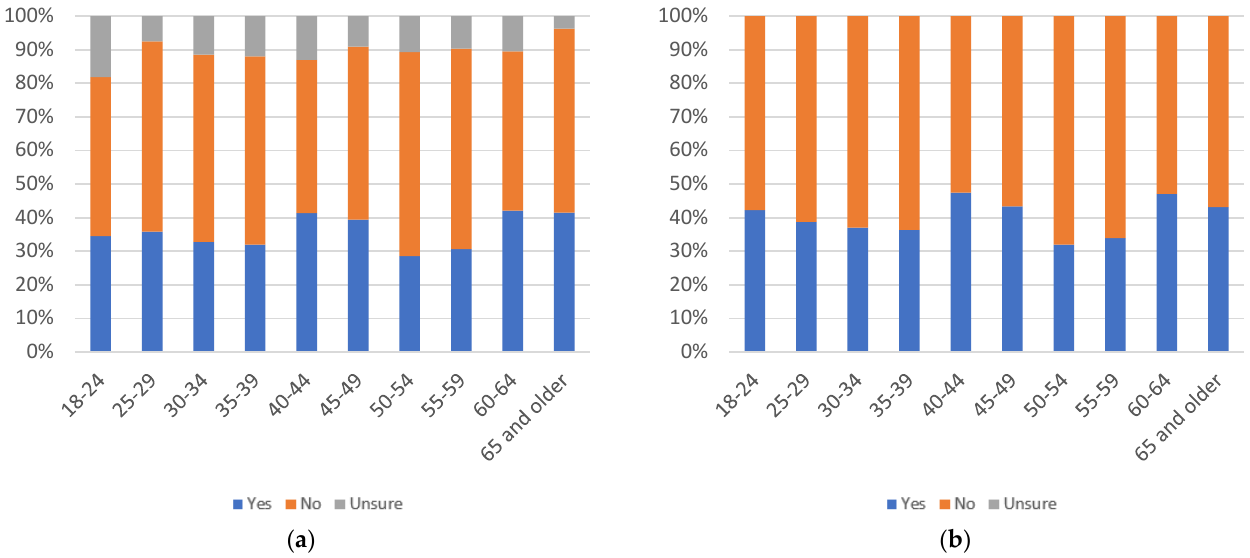
Figure 72. Label annoyingness, by age group: ( a ) with uncertain respondents (left) and ( b ) without uncertain respondents (right).